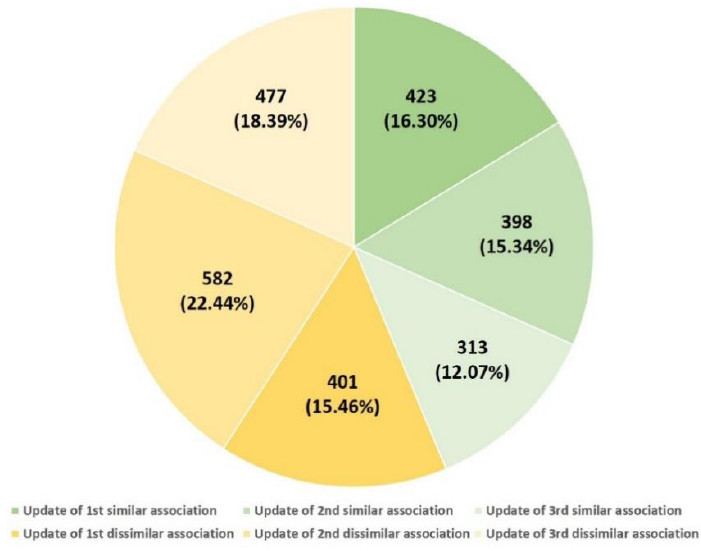
Figure 13. Times of updates in the association table.